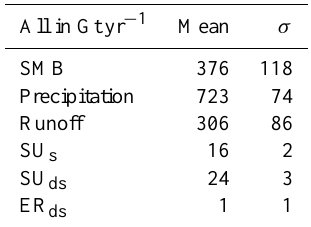
Table 2. Mean (1960–2011) and standard deviation (square root of the interannual variability) of ice sheet-integrated values (Gt yr − 1 ) of the SMB and its